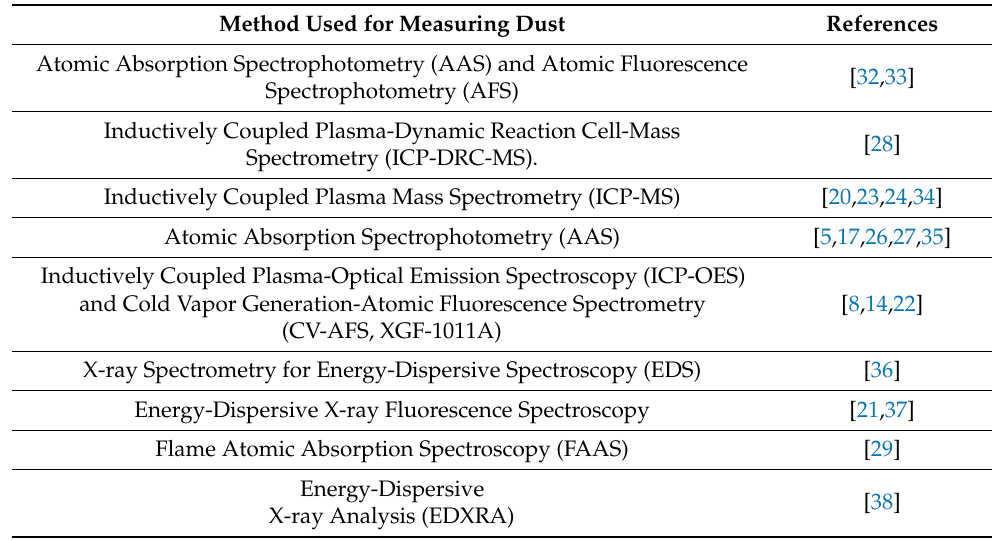
Table 1. A summary of the dust measurement